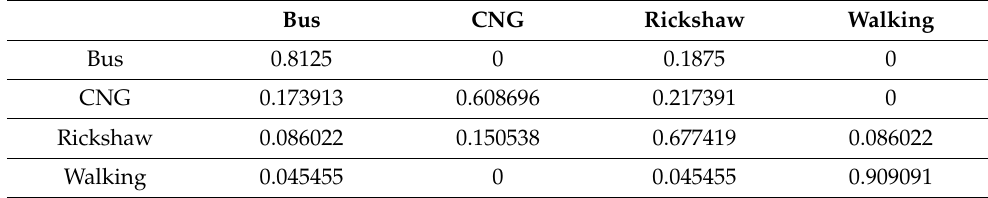
Table 7. Confusion matrix